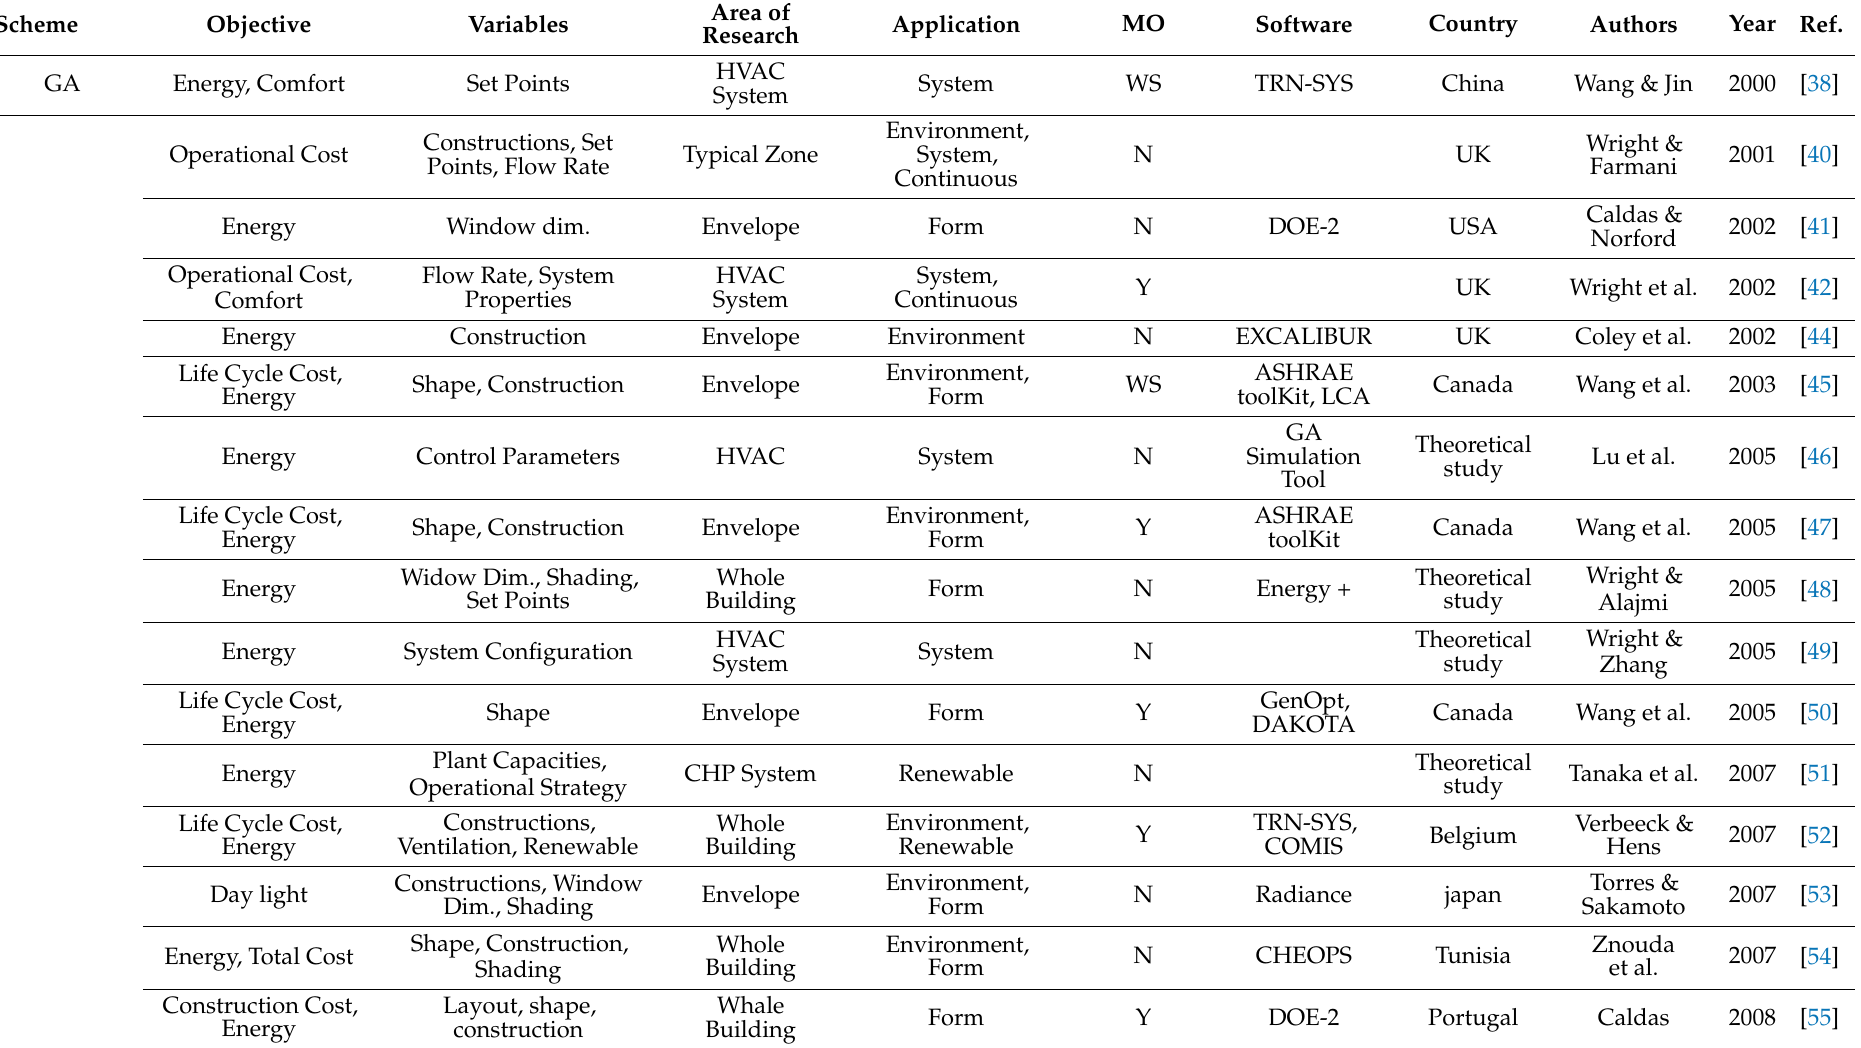
Table 1. Basic statistic summary of the GA and its